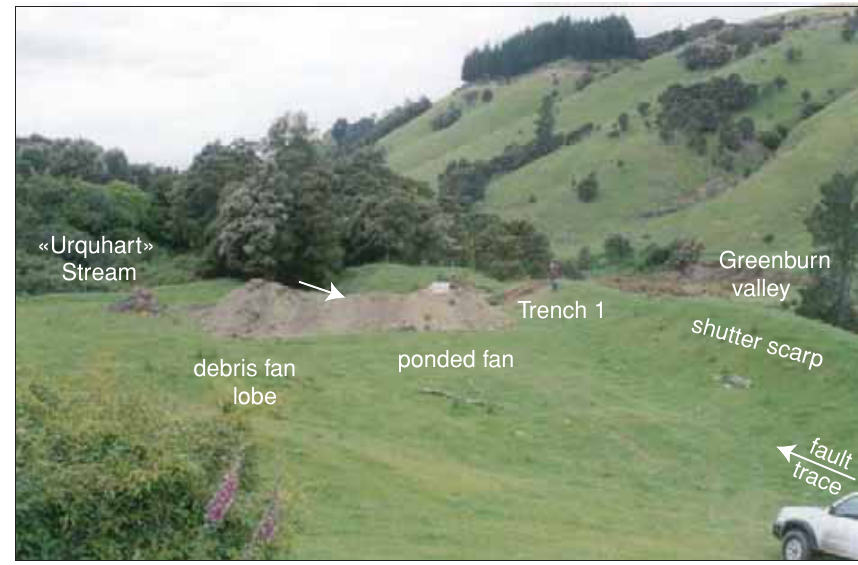
Fig. 4. The Greenburn Stream site with vehicle for scale. View to the east shows Trench 1 excavated through the shutter scarp and into the ponded alluvial fan surface. The site is elevated above modern «Urquhart Stream» and Greenburn valley. Drainage at the site was from left to right. Recent incision by Urquhart Stream has aban- doned this